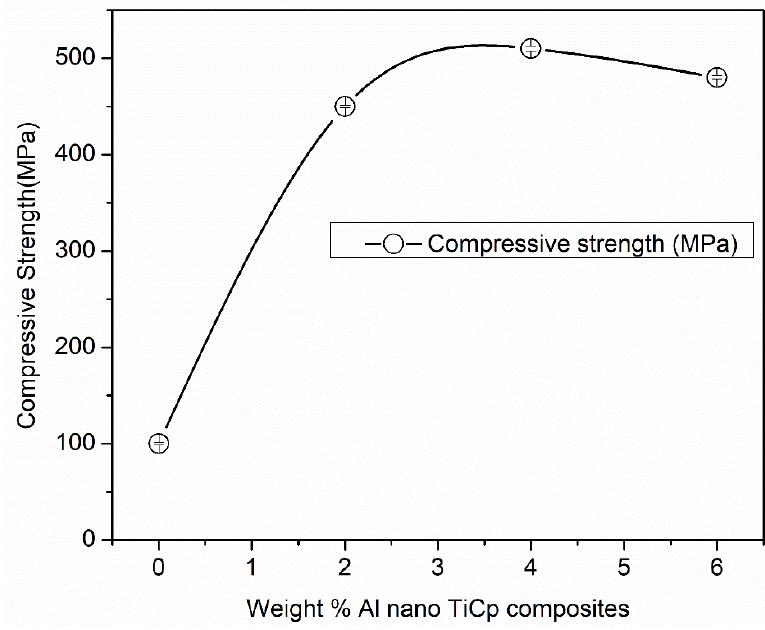
Figure 6. Al nanoTiC p composites compressive strength.